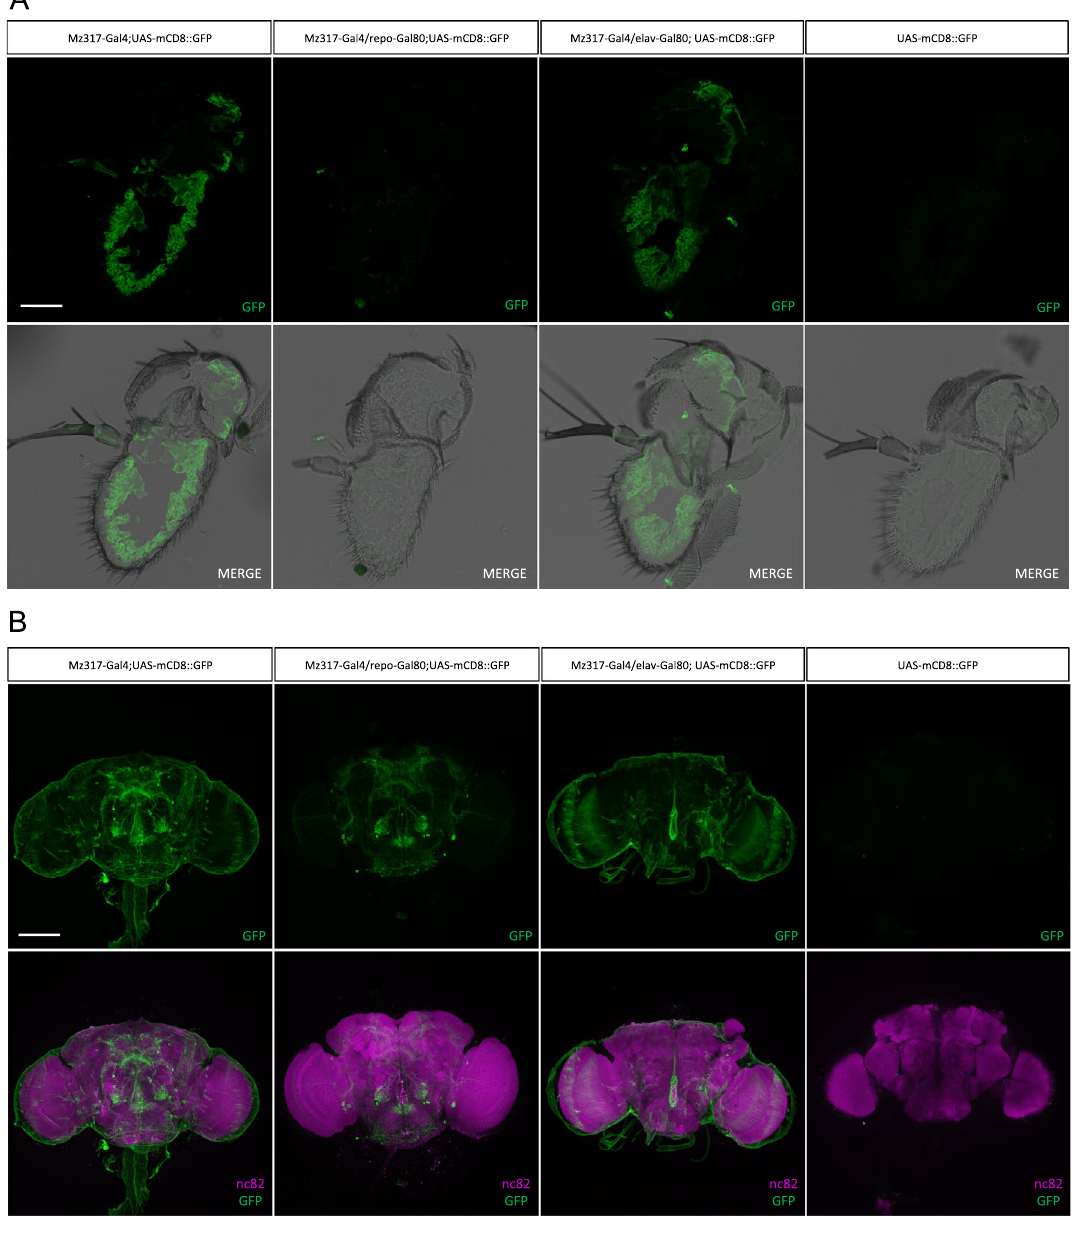
Figure 3. Analysis of GFP expression in the Mz317-Gal4 line. ( A ) Immunohistochemistry on antennal cryosections (14 µm) with anti-GFP antibody (green) on the following genotypes: Mz317-Gal4;UAS- mCD8::GFP , Mz317-Gal4/repo-Gal80;UAS-mCD8::GFP , Mz317-Gal4/elav-Gal80;UAS-mCD8::GFP and UAS-mCD8::GFP . Scale bar represents 40 µm. ( B ) Immunohistochemistry on brain dissections with anti-GFP (green) and anti-nc82 (magenta) antibodies on Mz317-Gal4;UAS-mCD8::GFP , Mz317-Gal4/repo-Gal80;UAS- mCD8::GFP , Mz317-Gal4/elav-Gal80;UAS-mCD8::GFP and UAS-mCD8::GFP . Scale bar represents 100